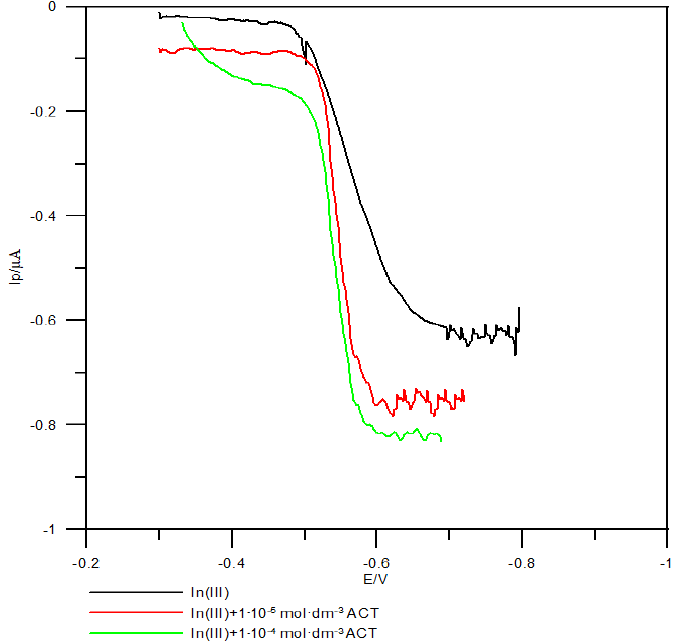
Figure 1. DC voltammograms of 1 × 10 − 3 mol · dm − 3 In(III) electroreduction in 1 the mol · dm − 3 chlorates(VII) solution in the acetazolamide presence. The concentrations of acetazolamide are given on the plot.